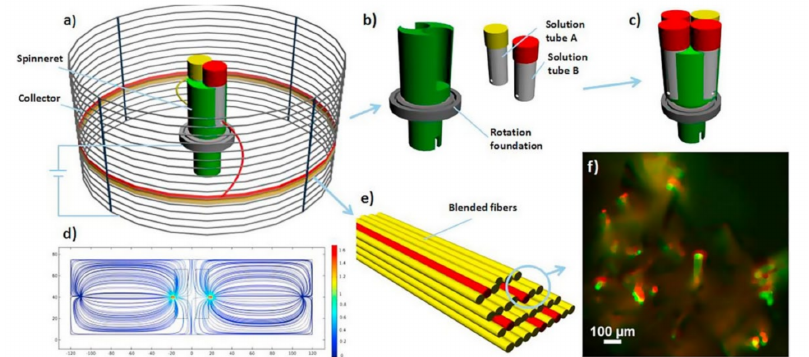
Figure 3. Schematic diagram of centrifugal electrospinning. ( a ) Structure chart; ( b ) rotating device; ( c ) nozzle is mounted on a rotating body; ( d ) electric field distribution map; ( e ) composite fiber; ( f ) fluorescence image of composite fiber